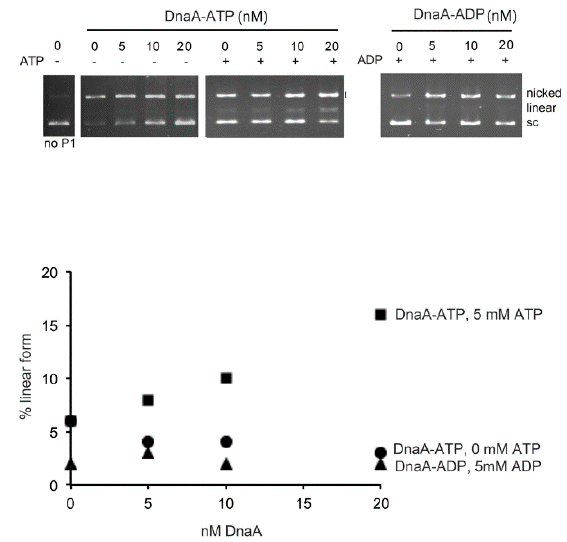
Figure 6. ATP-DnaA requires additional ATP mix to unwind oriC . ( Top ) supercoiled oriC plasmid was incubated with the indicated concentrations of ATP-DnaA or ADP-DnaA in the absence or presence of 5 mM ATP or 5 mM ADP. After P1 endonuclease digestion, DNA species were resolved by electrophoresis. The supercoiled (sc), nicked, and linear forms are marked; ( Bottom ) the linear form generated by P1 digestion in the presence or absence of 5 mM ATP and 5 mM ADP respectively were quantitated.